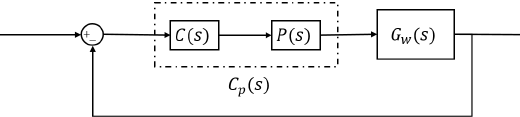
Figure 6. Schematic of the decoupling controller.